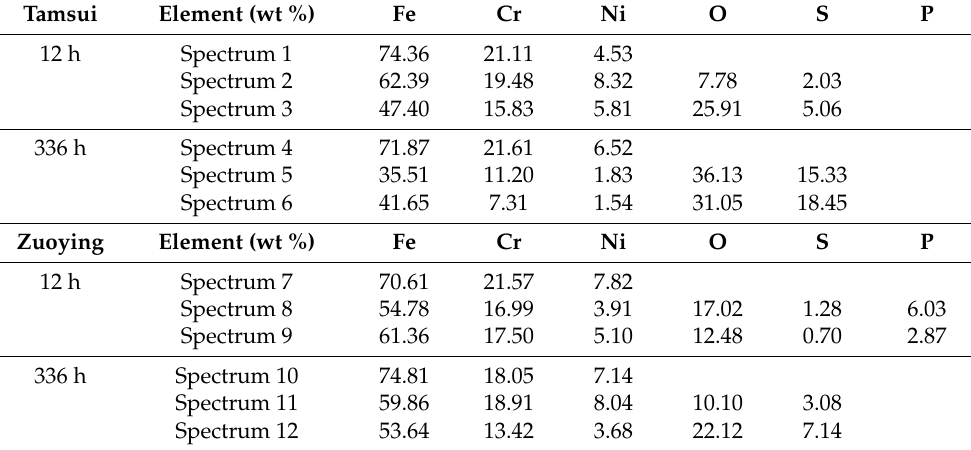
Table 2. Elemental composition ratio on the surfaces of 304 SS corresponding to the Tamsui and Zuoying inocula.